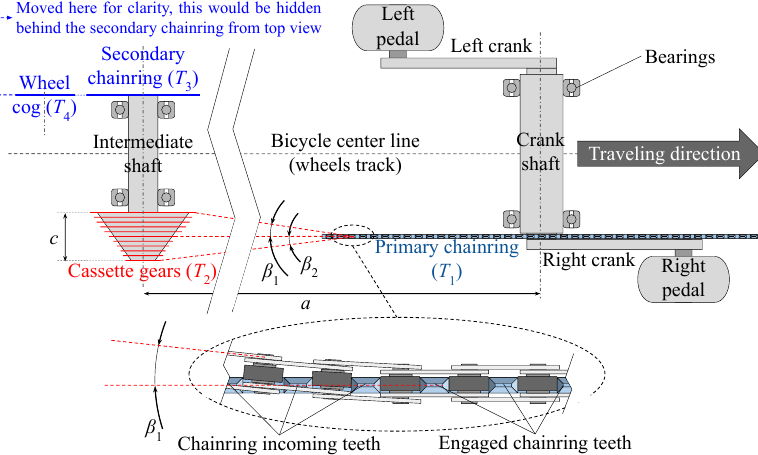
Figure 2. Top view of a FWD transmission and chainline